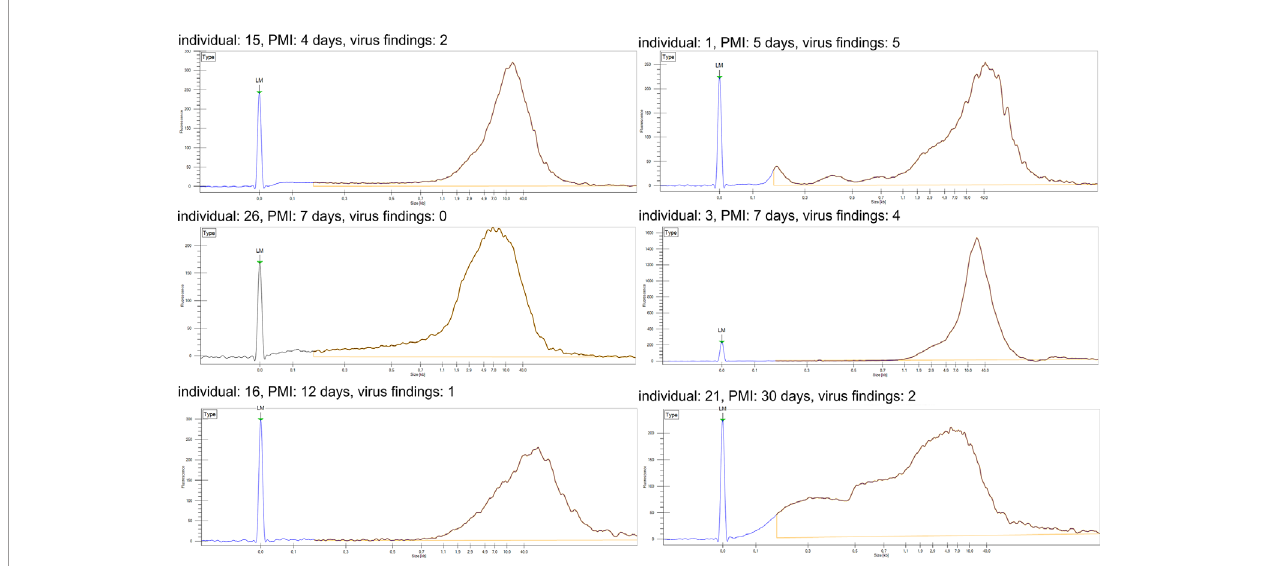
FIGURE 2 | DNA fragment analysis of total DNA. Fragment length distribution of genomic DNA for six representative samples as established with LabChip GX. Individual number refers to Figure 1 . LM, lower marker; PMI, post-mortem